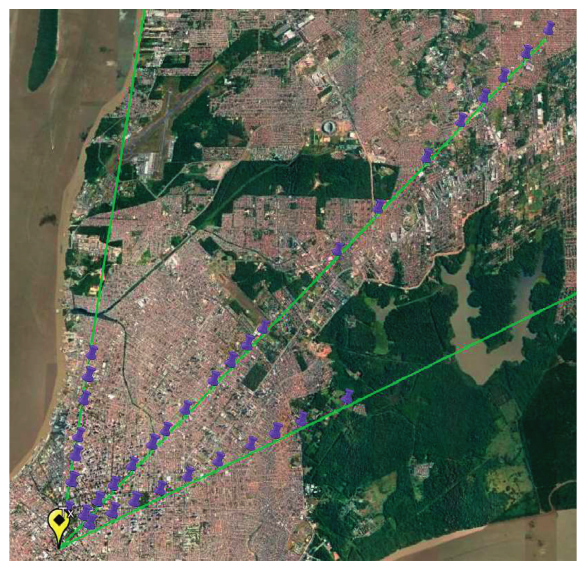
Figure 1: Measured points. Radials 1, 2, and 3 (adapted from